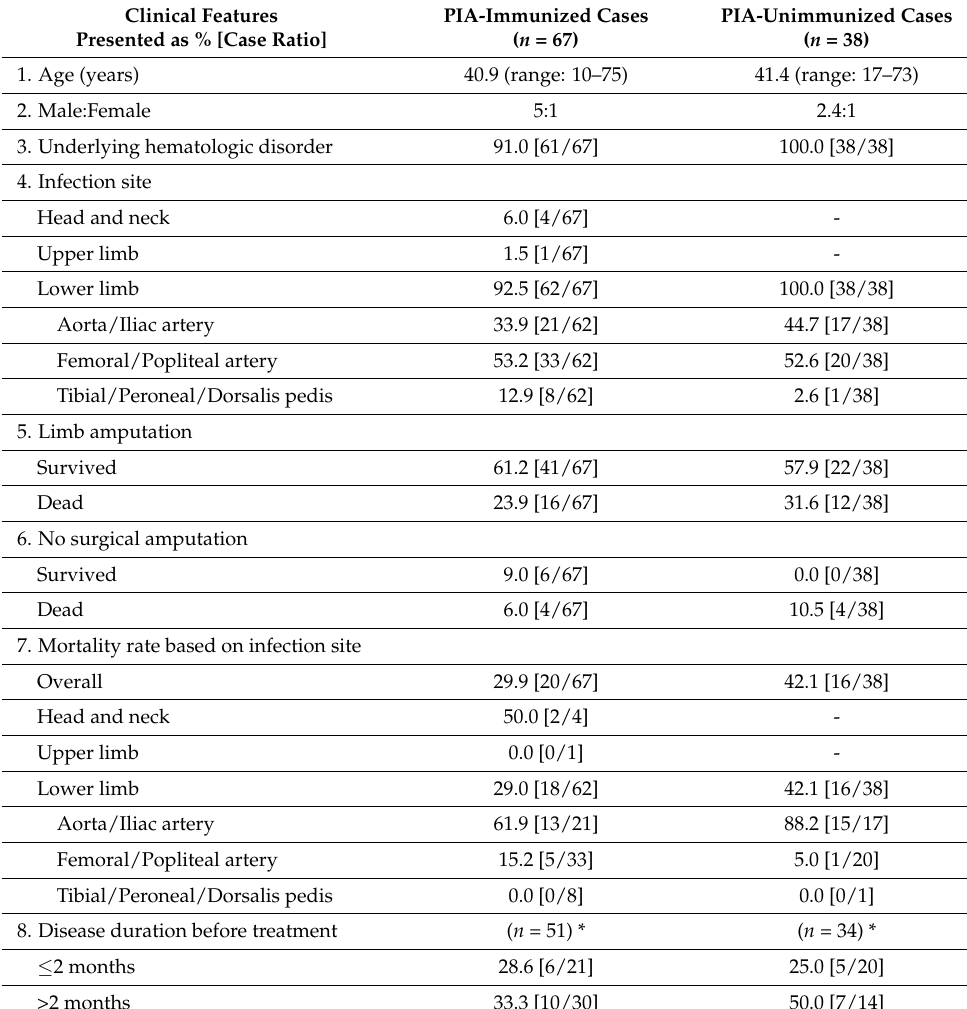
Table 3. Clinical details and treatment outcomes of vascular pythiosis patients with (67 cases) or without (38 cases) the P. insidiosum antigen (PIA)